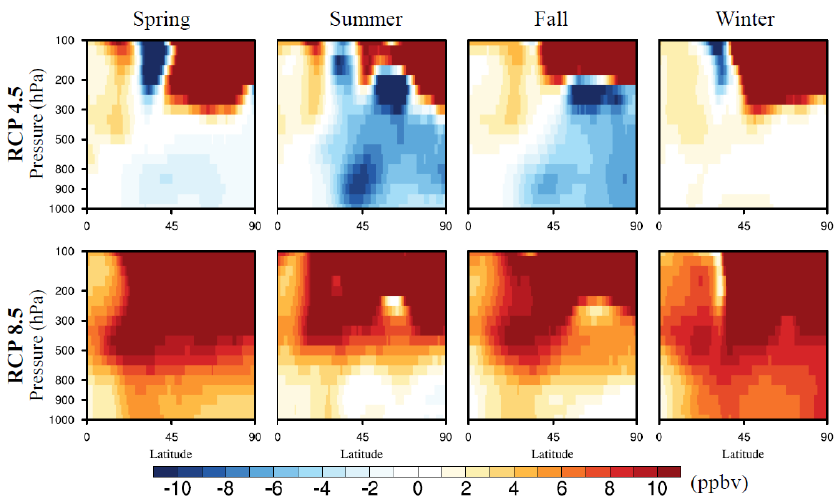
Fig. 4. Zonal mean vertical ozone changes from CAM-Chem under future climate (2057–2059 minus 2001–2004) for RCP 4.5 (top panel) and RCP 8.5 (bottom